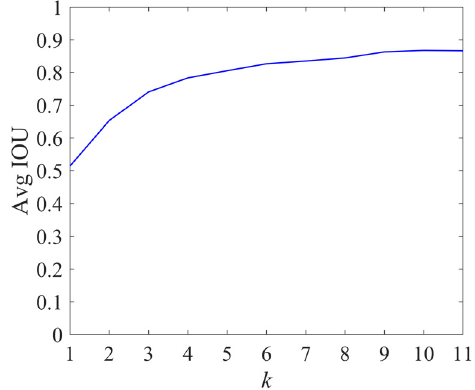
Figure 5. The change curve of Avg IOU.